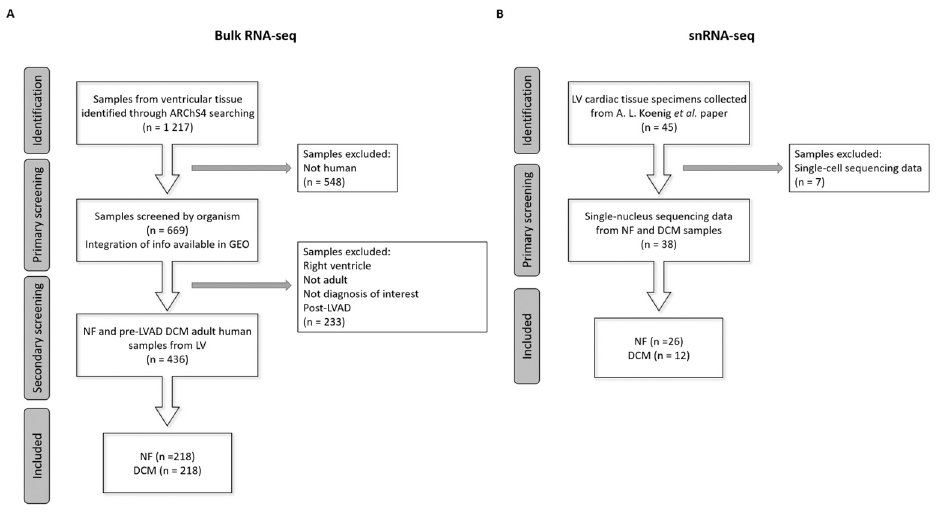
Figure 4. Flow chart of data collection. ( A ) Bulk RNA sequencing (RNA-seq) data of 1217 samples from ventricular tissue were retrieved from ARChS4 database. The primary screening was performed based on the organism, and 669 human samples were selected. Additional information for all samples were manually searched in GEO database and used for the secondary screening. In particular, we finally extracted the data of 436 adult non-failed (NF) and dilated cardiomyopathy (DCM) patients from the left ventricle (LV) before left ventricular assist device (pre-LVAD) implantation. ( B ) Single-cell and single-nucleus RNA sequencing (snRNA-seq and snRNA-seq) data from 45 LV cardiac tissue specimens were extracted from the paper of Koenig et al. [33]. The screening was performed based on the sequencing approach and 38 samples analyzed through snRNA-seq were selected. The latter were composed of 26 NF and DCM patients.